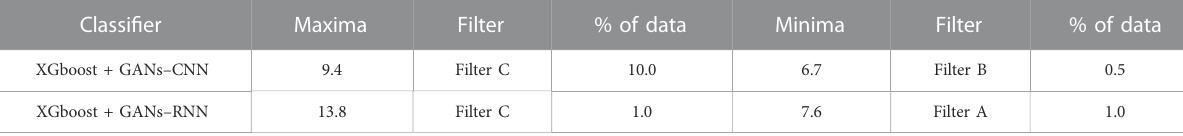
TABLE 4 Enrichment Ratios of ADRB2 on the original dataset with no feature selection with training size of 30%.